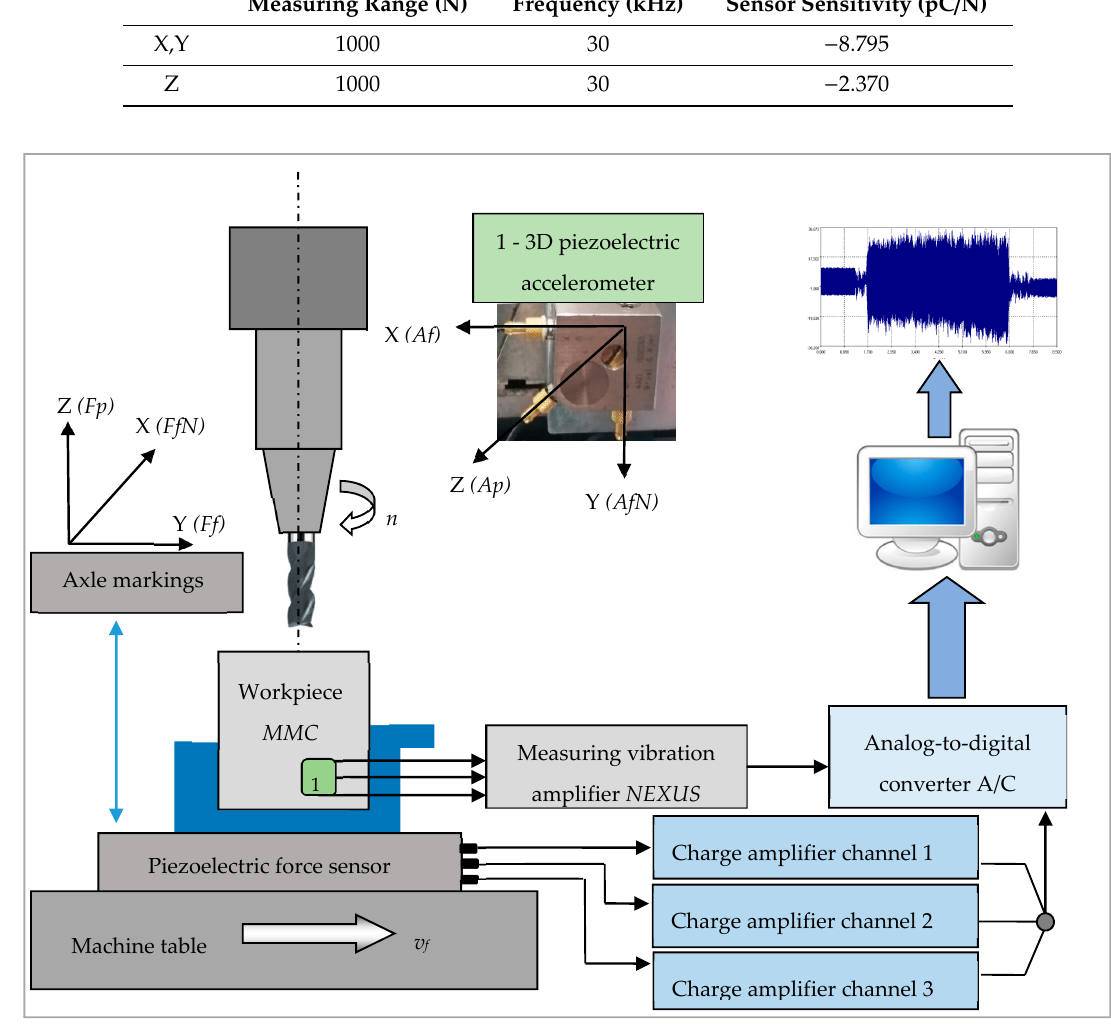
Figure 2. Scheme of experimental set up.